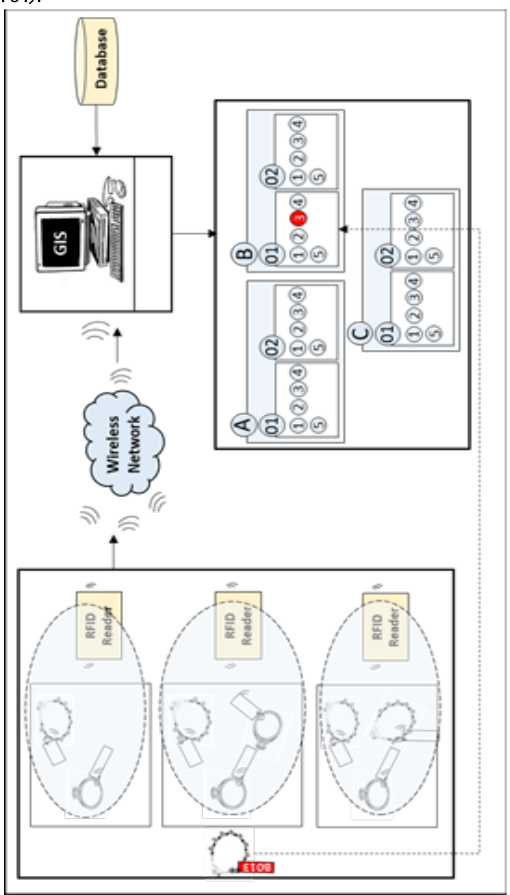
Figure 3. Architecture of the proposed